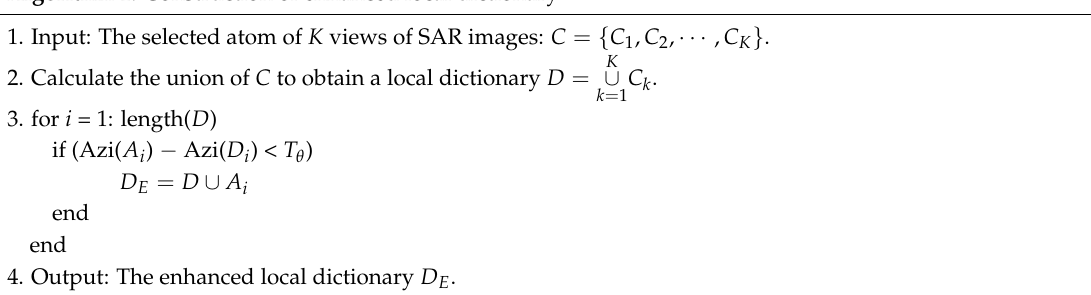
Algorithm 1. Construction of enhanced local